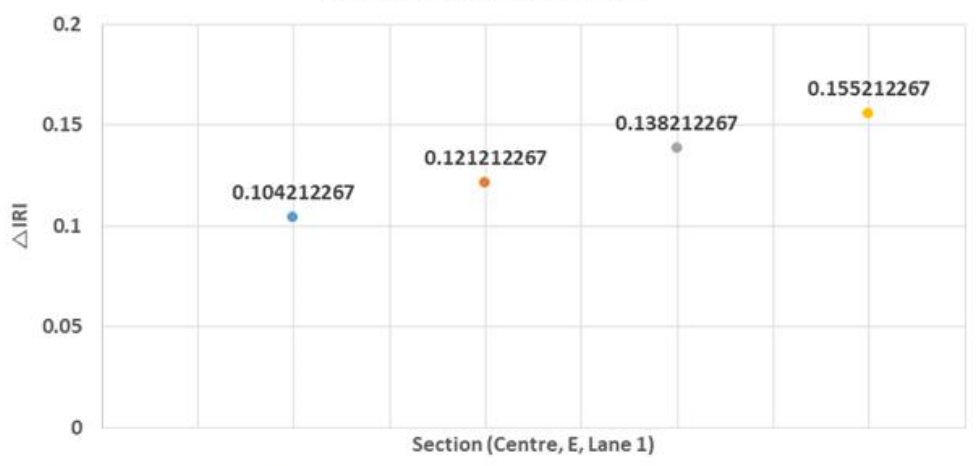
∆ IRI relationship (ASR grade 1–4). Figure 4. Total section–ΔIRI relationship (ASR grade 1–4). Figure 4. Total section–